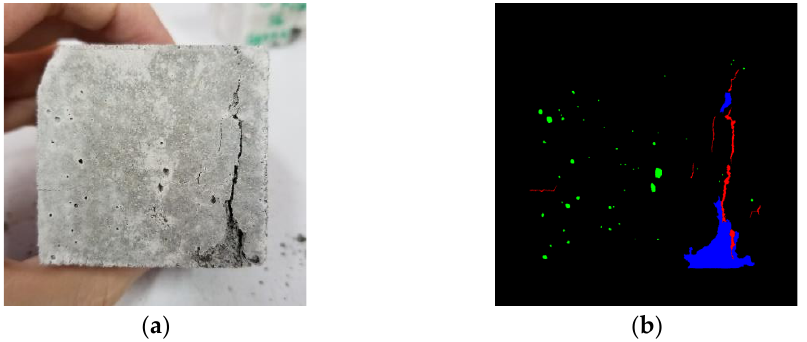
Figure 5. ( a ) RGB Image; ( b ) ground truth image. Voids are visualized as green, spallings are visualized as blue, and cracks are visualized as red.